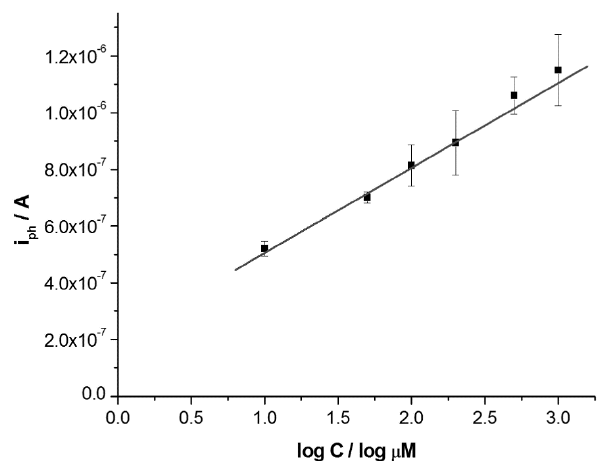
Figure 5. Plot of photocurrent as a function of logarithm of hydrazine